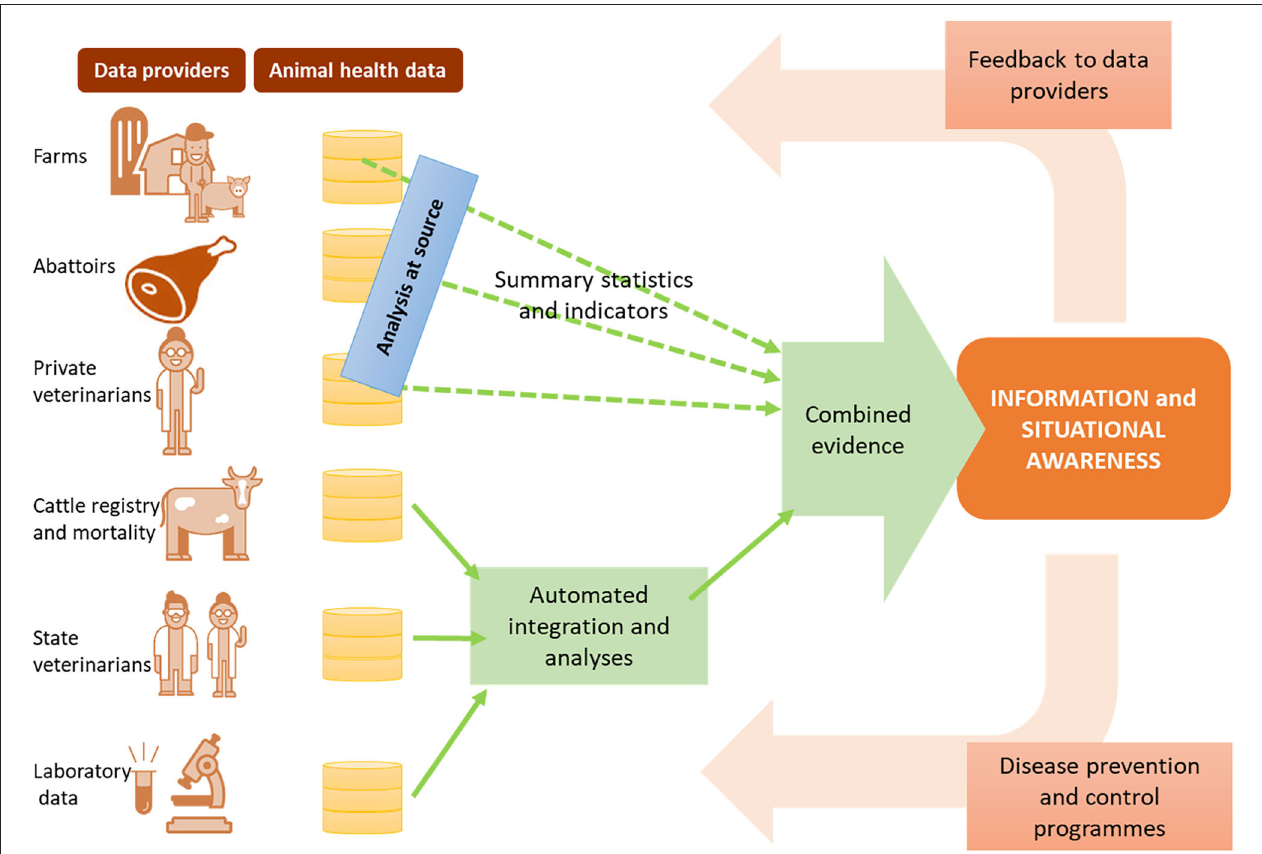
FIGURE 3 | Data-driven surveillance framework being developed in Sweden, as an example of how information and evidence can be produced from multiple data sources without relying on data sharing.